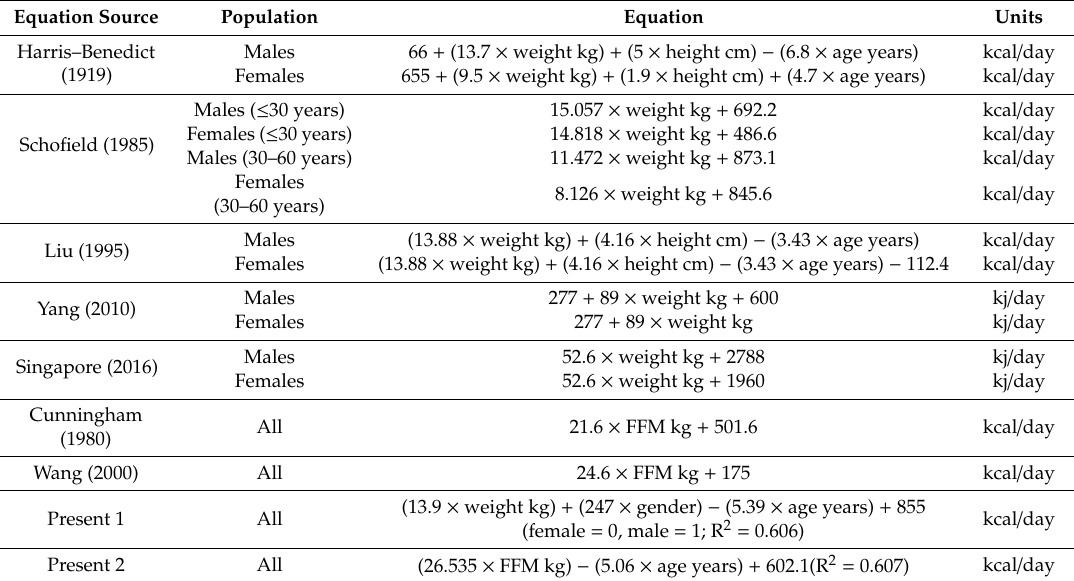
Table 1. Equations for resting metabolic rate (RMR). Note: FFM, fat-free